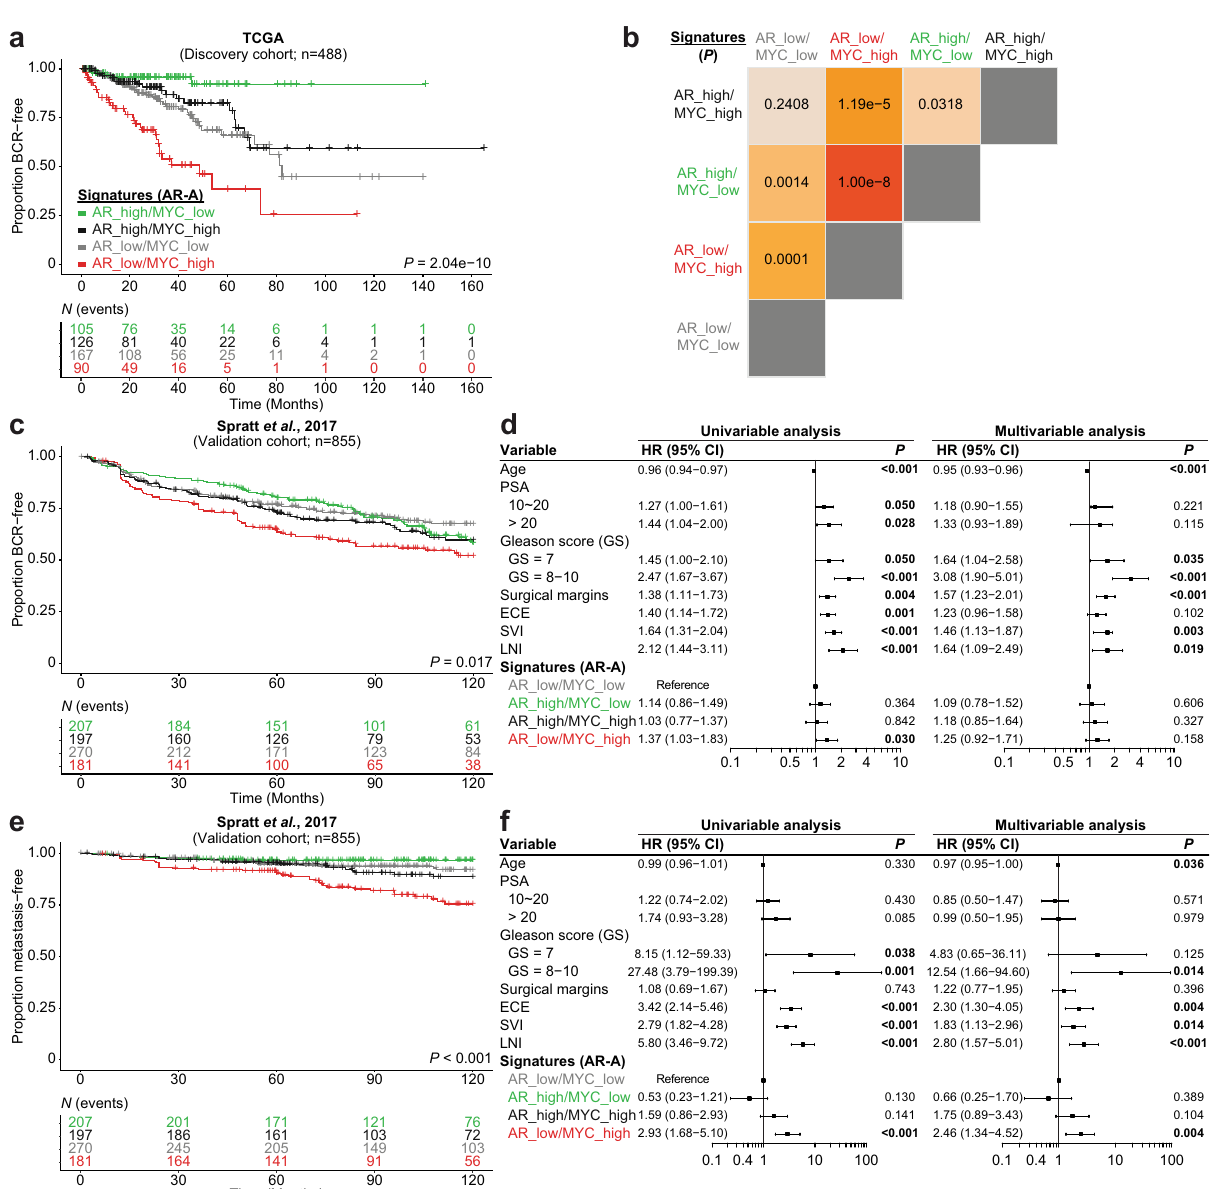
Fig. 4 MYC overexpression alters the AR cistrome. a AR ChIP-seq identi fi es an androgen response element (ARE) as the top AR binding motif in WT and MYC-transformed VP (VP; n = 2 pools of biological replicates ( n = 8 – 13) per genotype). b Unsupervised pairwise correlation of the murine AR cistrome from all specimens (VP; n = 2 pools of biological replicates ( n = 8 – 13) per genotype). c MYC overexpression expands the AR cistrome as demonstrated by the heatmaps indicating AR binding intensity across 4 kb intervals (VP; n = 2 pools of biological replicates ( n = 8 – 13) per genotype). d Motif analysis of